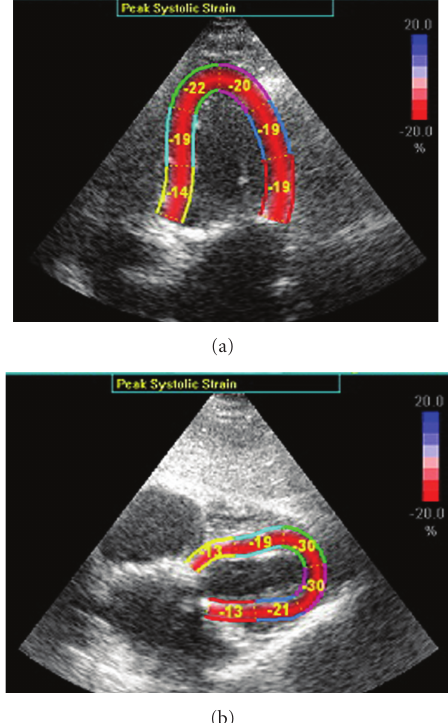
Figure 5: Apical (a) and subcostal (b) four-chamber view from the same patient. Segmental peak systolic strain values are indicated. Apex of the heart can be di ffi cult to recognize in the subcostal view and peak systolic strain values appear to be significantly higher at the apex of the subcostal view than the apical view. See text for further